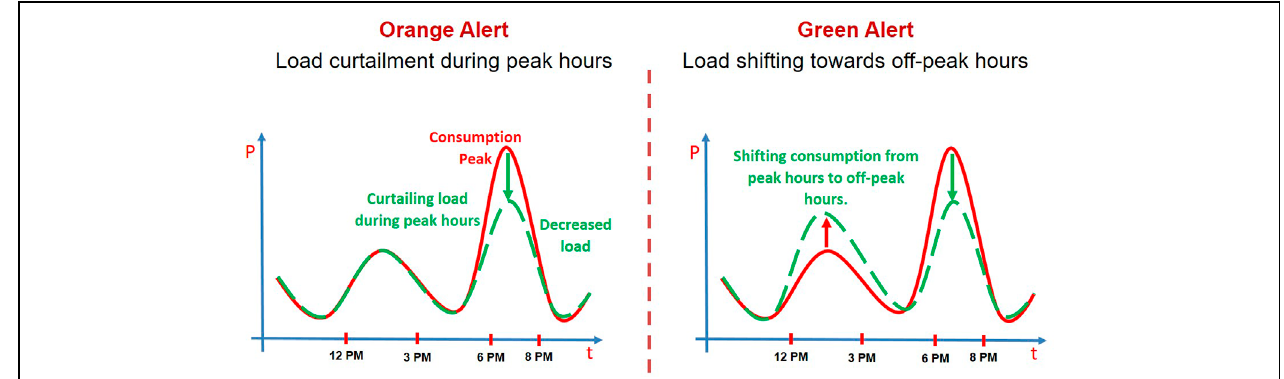
FIGURE 2 | Influencing indirect flexibility in an Energy Community using nudge signals (Shahid et al., 2021).